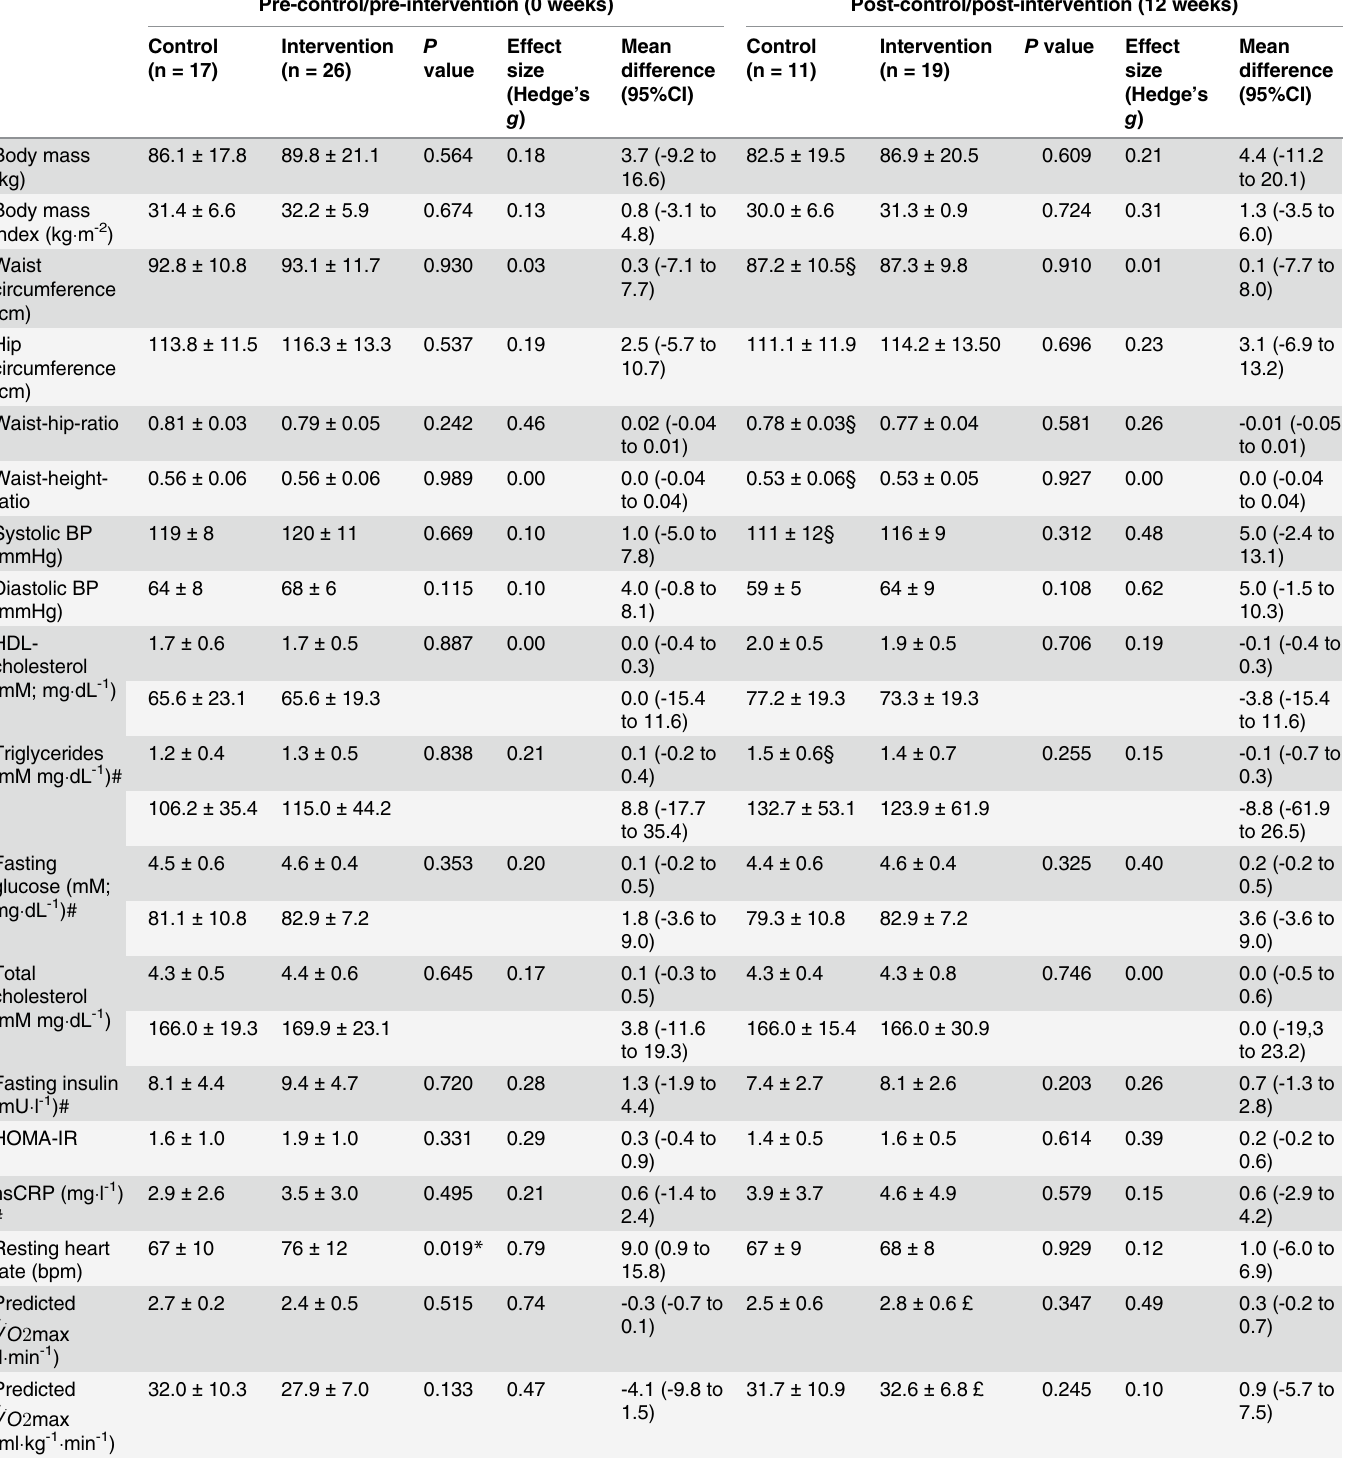
Table 1. Between-group comparisons of cardiometabolic risk factors for the intervention and control group at pre (0 weeks) and post (12